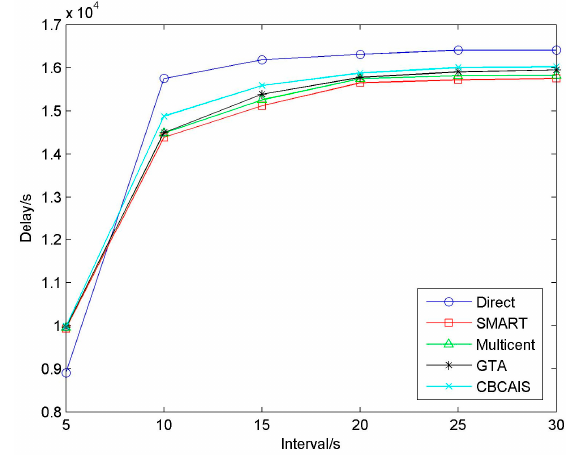
Figure 18. Delivery delay for varying message generation intervals.